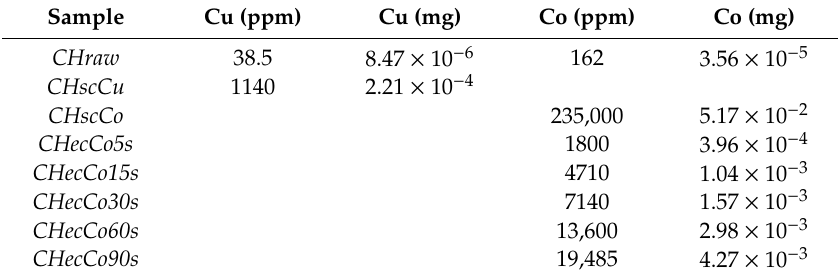
Table 2. Metal content from ICP-AES analysis after sonochemical ( CHsc ) and electrochemical ( CHec ) deposition of Cu and Co on CHraw . Values in ppm (mg / kg) and mg present in 20 µ L of